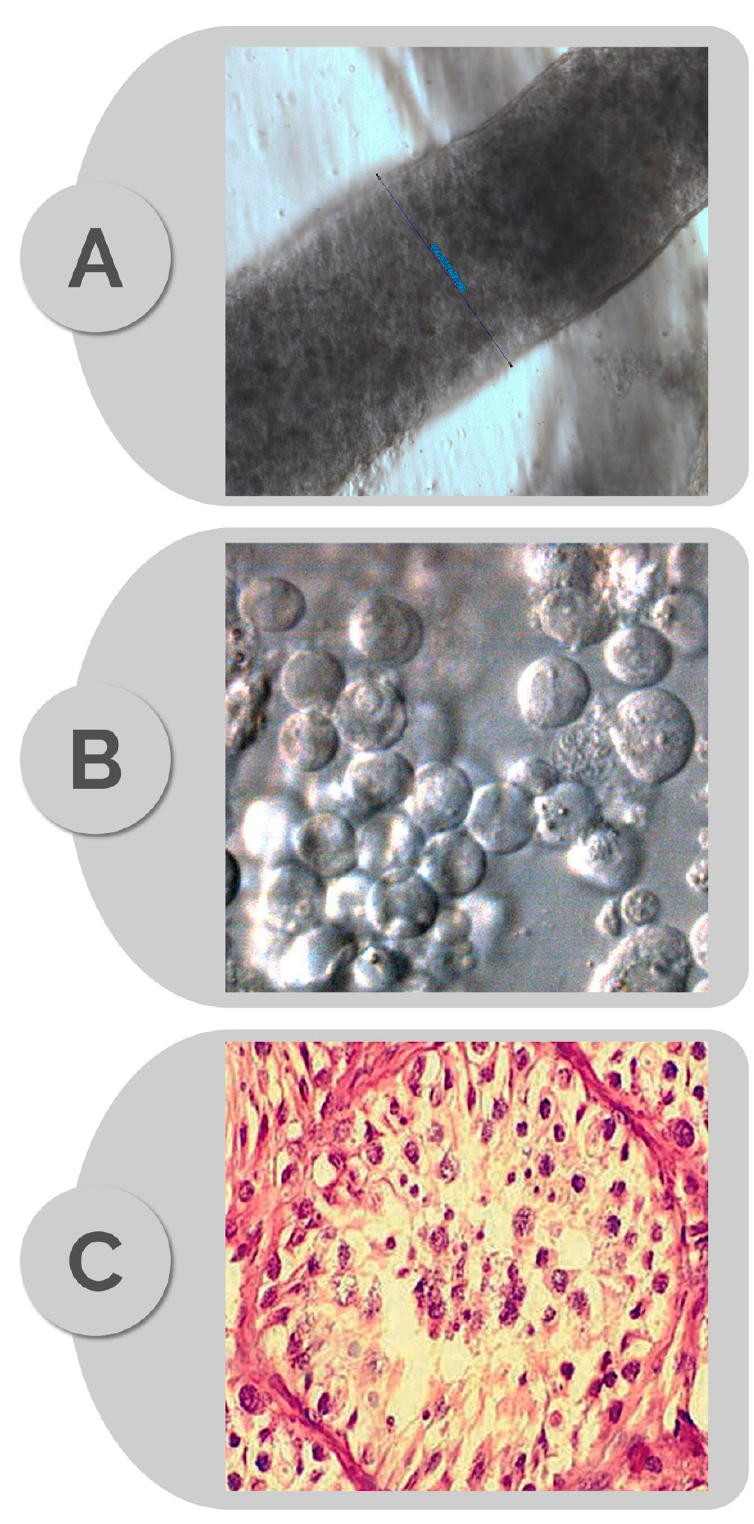
Figure 2. Photomicrographs illustrating: ( A ) intact seminiferous tubule (diameter 270 micrometers), ( B ) cell suspension obtained after mechanical tubule mincing, and ( C ) corresponding histopathology (hematoxylin/eosin) specimen revealing germ cell maturation arrest (MA). Images A and B obtained at 400 × magnification using an inverted optical microscope (Nikon Eclipse Diaphot 300, Nikon, Japan, with phase contrast